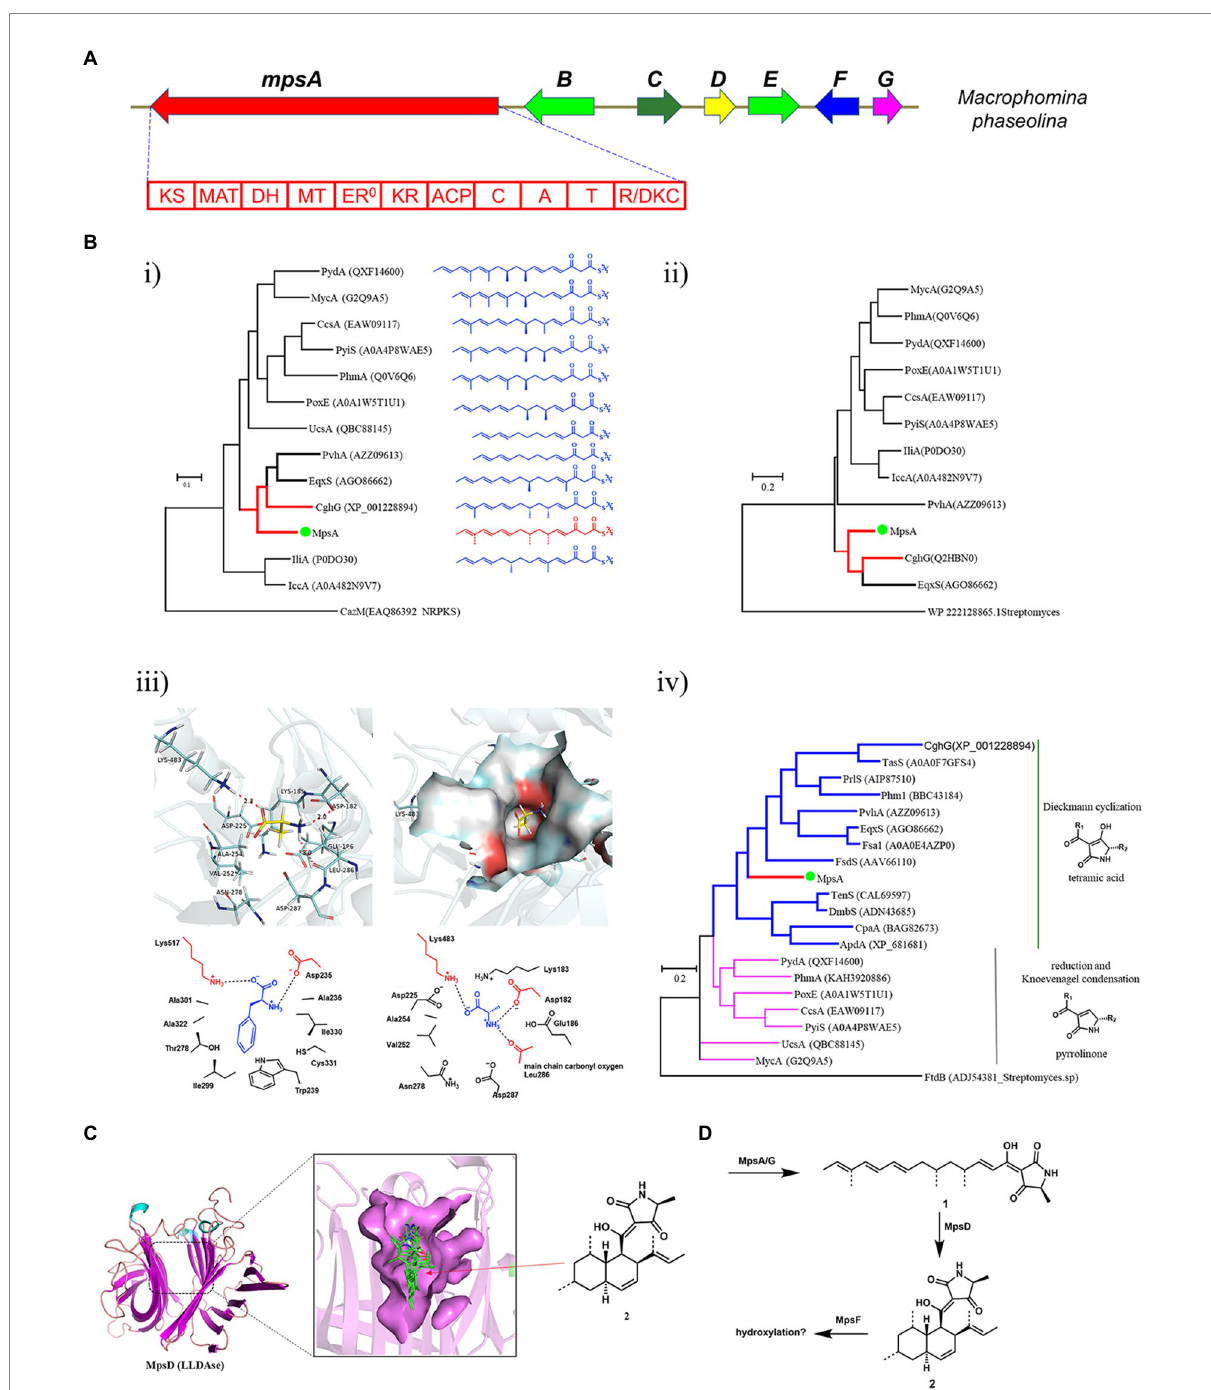
FIGURE 2 Bioinformatics analysis of the mps cluster. (A) The mps cluster identified from M. phaseolina . mpsA encodes PKS-NRPS, mpsB encodes transcription factor, mpsC encodes transporter, mpsD encodes LLDAse, mpsE encodes transcription factor, mpsF encodes cytochrome P450, mpsG encodes trans-acting ER. (B) Bioinformatics analysis of the domains identified from MpsA. (i) The phylogenetic tree of KS domains; (ii) The phylogenetic tree of MT domains; (iii) Structure-based prediction of the substrate of MpsA A domain; (iv) The phylogenetic tree of R/DKC domains. (C) Structure-based prediction of the product of MpsD. (D) The predicted metabolites encoded by mps